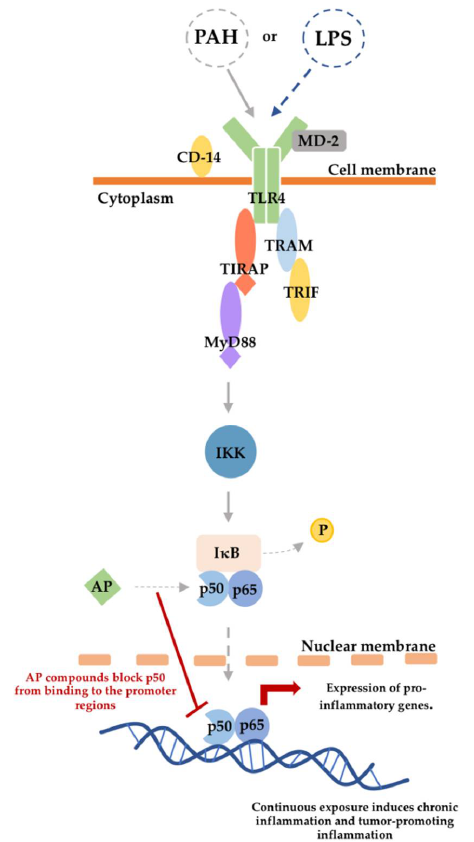
Figure 1. Mechanistic pathway of PAH-induced inflammation via the TLR4 pathway and AP inflammatory inhibition via the canonical NF-κB pathway.